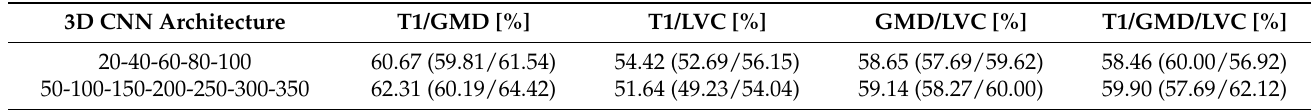
Table 5. Results for 3D CNNs learned on all combinations of the three types of features (T1, GMD, and LVC). The metrics listed represent the accuracy (sensitivity/specificity) in percentage. 3D CNN